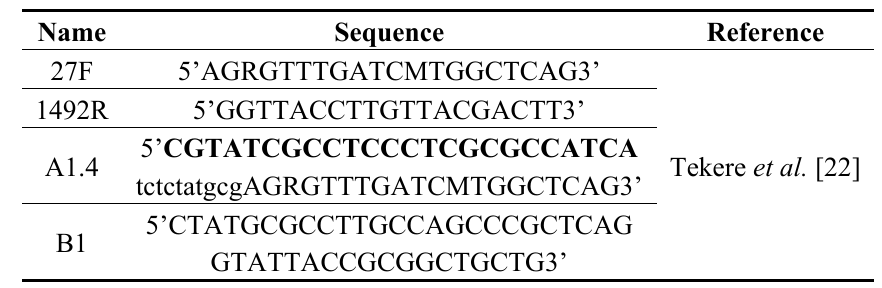
Table 1. Primers used in this study.